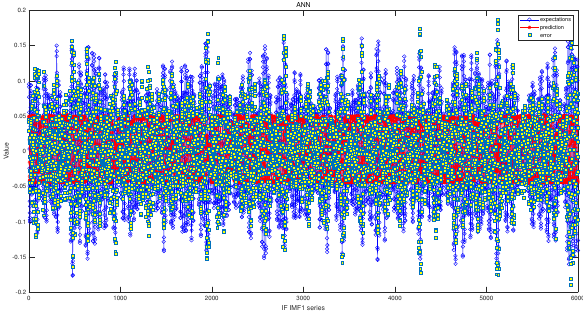
Figure 5. Prediction result of ANN model for IF IMF1 time series.